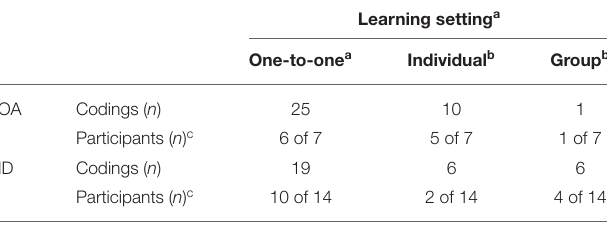
TABLE 3 | Results of the content analysis for learning